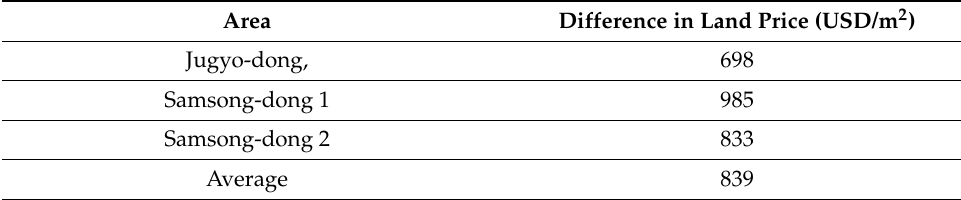
Table 8. Difference in land prices between 2007 and